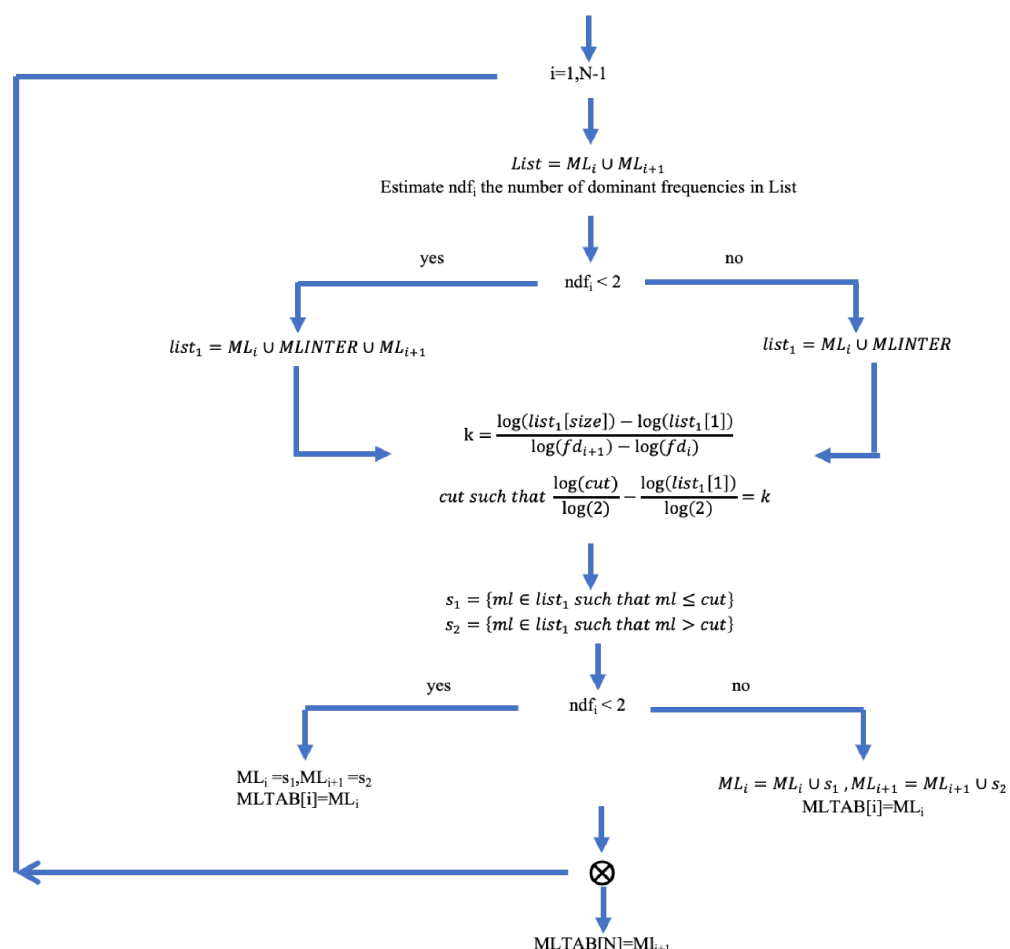
Figure 2. Calculation of the MLTAB matrix. Each row of MLTAB contains the list of significant local maxima present in the spectrum of an IMF. The rows of MLTAB have no common elements, and therefore MLTAB can be seen as a set of non-overlapping local maximum groups and represents a segmentation of the original signal Fourier